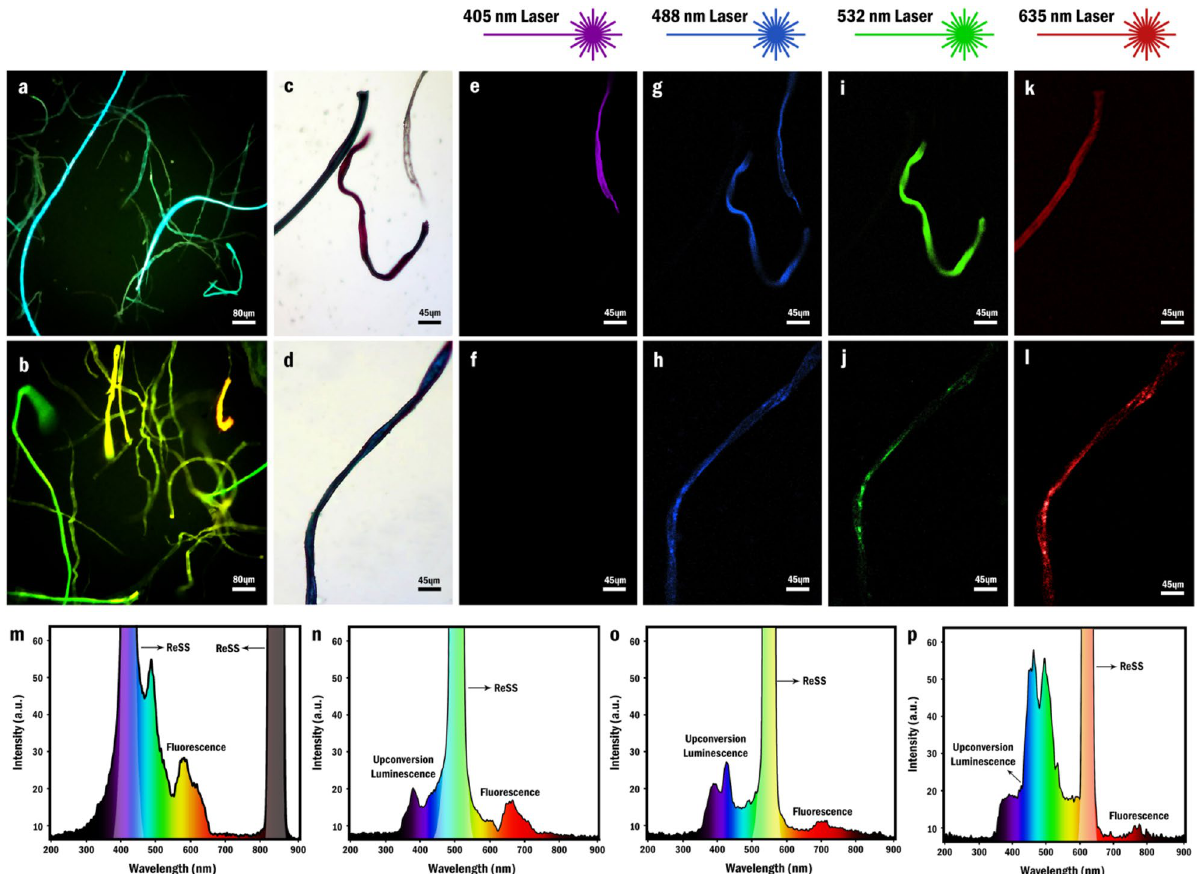
Figure 7. Fluorescence microscopy and confocal laser scanning microscopy of dried NOG fibers, ( a ) FLM image of NOG fibers’ cyan blue fluorescence by using UV filter ( b ) FLM image of NOG fibers’ green, yellow and red emissions by using blue filter ( c – d ) OM images of colorless, blue, red and dark green fibers ( e – f ) Violet channel CLSM images of NOG fibers ( g – h ) Blue channel CLSM images of NOG fibers ( i – j ) Green channel CLSM images of NOG fibers ( k-l ) Red channel CLSM images of NOG fibers ( m – p ) PL emission spectra of the NOG fibers with ʎ ex of 405, 488, 532 and 635 nm